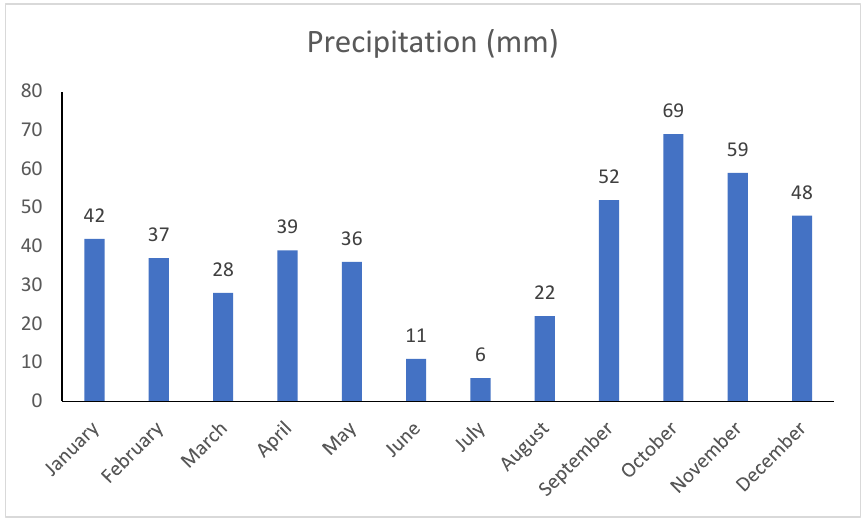
Figure 3. Monthly rainfall distribution at Palma’s Harbour gauge, 1981–2020. Source: AEMET.